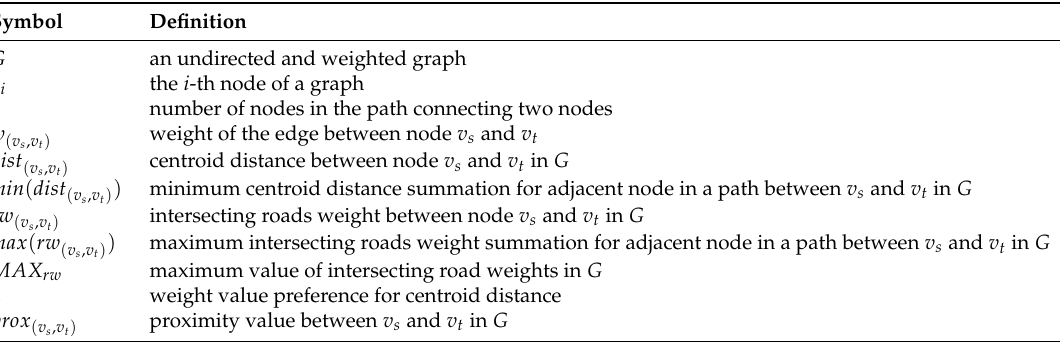
Table 4. Frequently used